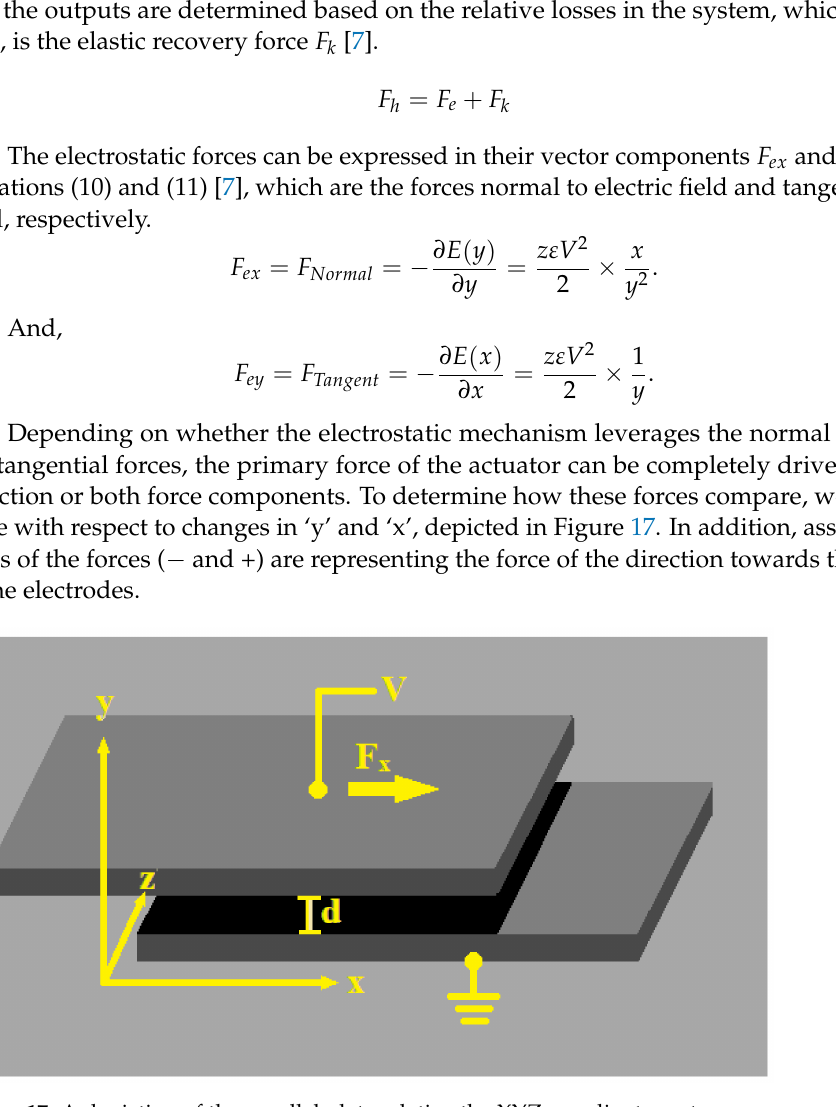
Figure 17. A depiction of the parallel plate relative the XYZ coordinate